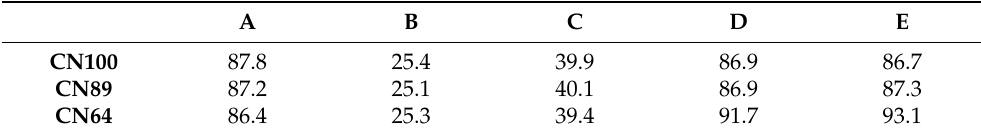
Table 2. Relative area (%) where the dangerous threshold for erosion τ bs > τ c holds. A B C D E